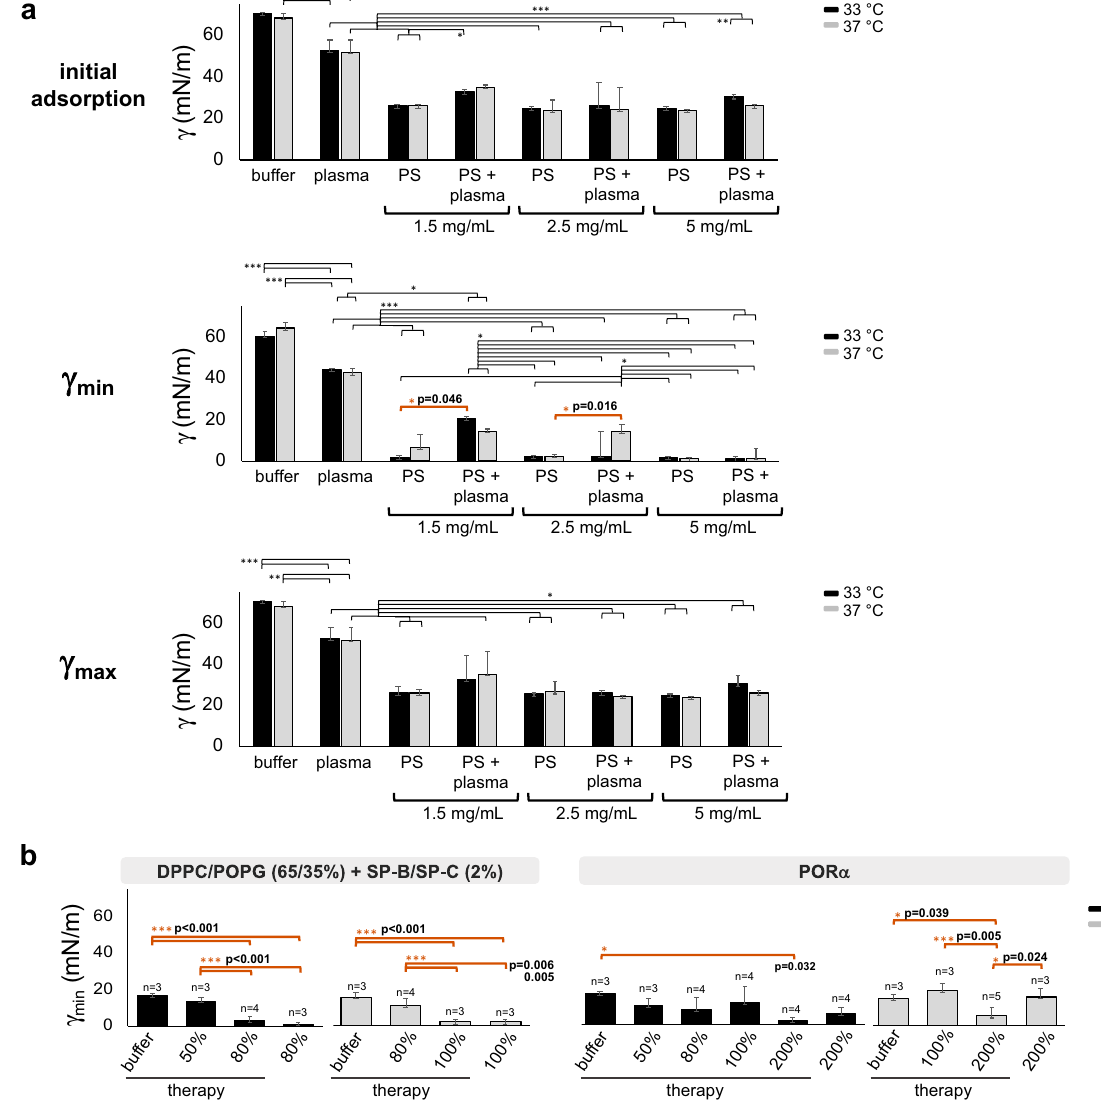
Figure 4. PS inhibition by plasma and restoration at different temperatures. ( a ) CDS experiments of PS are shown at different concentrations at the 2 temperatures (1.5 (n = 4), 2.5 (n = 3) and 5 (n = 3) mg/mL) with and without plasma (68 mg/mL of plasma total proteins (TP)), corresponding to 1.6, 2.6 and 5.2% PLs/plasma TP. Initial adsorption along with minimum and maximum surface tensions upon 10 slow compression-expansion cycles (2 cycles/min, shrinking the interface area by 20%, 0.2 cm 2 /min) are depicted compared to plasma (n = 3) and buffer alone (n = 3). ( b ) Restoration of PS activity after plasma inhibition, with 1.5 mg/mL and 2.5 mg/mL of PS at 33 °C and 37 °C. After inhibiting surfactant, several amounts of further surfactant were supplemented to mimic therapy, using PORα or the lipid-protein mixture [DPPC/POPG (65/35%, w/w) + SP-B/SP-C (2% total protein-to-lipid by weight)]. These supplemented amounts were calculated as the percentage of μg of PLs of therapy with respect to the μg of inhibited PS. As further controls, only buffer was dispensed as a mock therapy for inhibited PS and the restoration therapy was analysed in the presence of plasma alone. Black and light-grey bars represent experiments performed at 33 °C and 37 °C, respectively. Means and standard deviation of at least three replicates are shown. Horizontal lines represent statistical comparisons. Two-way ANOVA test followed by post-hoc test = (a) initial adsorption: temperature (n. s.), PS concentration (p < 0.001, D.F. = 3, F = 139.1) and plasma presence (n. s.); γ min : temperature (n. s.), PS concentration (p < 0.001, D.F. = 3, F = 139.1), plasma presence (n. s.), temperature/PS concentration/plasma presence (p < 0.006, D.F. = 3, F = 4.7); γ max : temperature (n. s.), PS concentration (p < 0.001, D.F. = 3, F = 124.7) and plasma presence (p < 0.001, D.F. = 1, F = 16.9). Paired t test γ min = 33 °C: PS at 1.5 mg/mL with and without plasma (p = 0.046, D.F. = 3, t = − 3.3), 37 °C: PS at 2.5 mg/mL with and without plasma (p = 0.016, D.F. = 3, t = − 5.0). One-way ANOVA test followed by post-hoc test = (b) synthetic lipid mixture: 33 °C (p < 0.001, D.F. = 3, F = 101), 37 °C (p < 0.001, D.F. = 3, F = 22.2); PORα: 33 °C (p = 0.044, D.F. = 5, F = 3), 37 °C (p = 0.004, D.F. = 3, F = 8.6). *p < 0.05 and > 0.01, **p ≤ 0.01 and > 0.005, ***p ≤ 0.005. The exact p values of the most relevant post-hoc tests are indicated. The corresponding comparison bars and symbols are highlighted in orange color. PS purified porcine surfactant, γ surface tension, min minimum, max maximum, DPPC dipalmitoylphosphatidylcholine, POPG palmitoyloleoylphosphatidylglicerol, SP-B surfactant protein B, SP- C surfactant protein C, PORα poractant α, n. s. not significant, D.F. degrees of